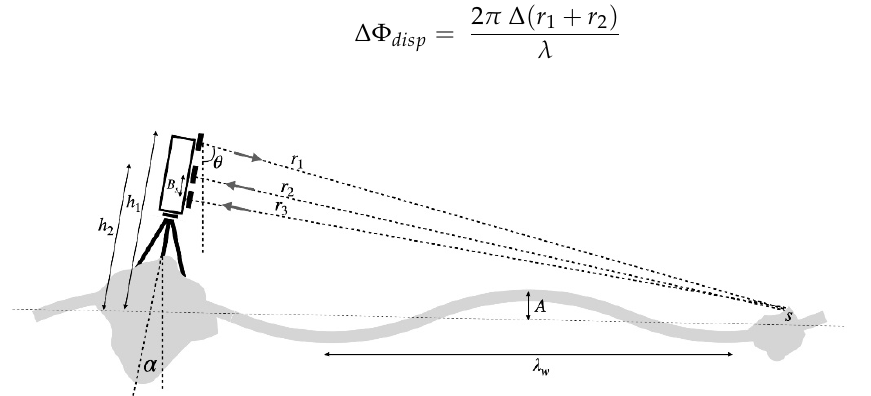
Figure 1. Geometry illustration of the GPRI mounted on a ridge. The three antennas are each associated with a height above the level ice surface, h , a range to a specific target, r , and an incident angle, θ . The GPRI is free to tilt at an angle, α , relative to a level reference point due to ocean waves with amplitude, A , and wavelength, λ w